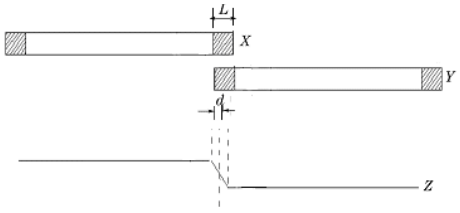
Figure 2. The sketch map of one-dimensional overlap The pixel i in the overlapped area is in the column of d in Y, and L is the column width of the overlapped area. Then the grayscale value after applying the gradient mosaic according to weighted coefficients is